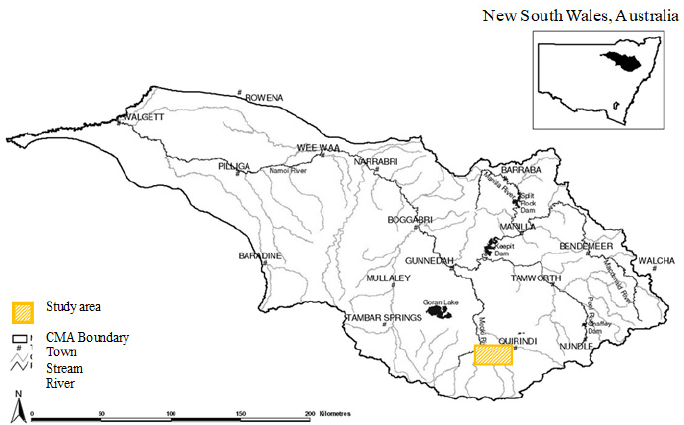
Figure 1. Location of study sites in Namoi catchment, New South Wales, Australia.